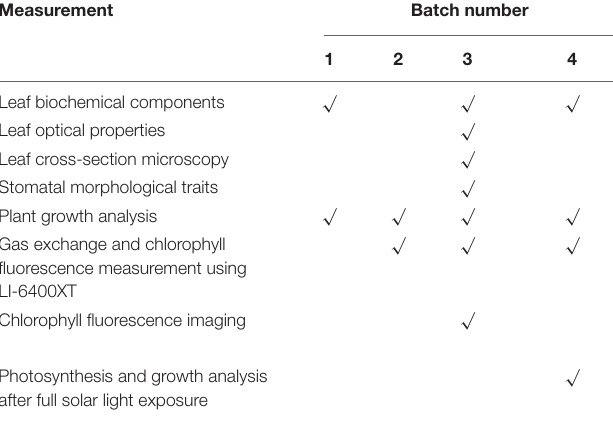
TABLE 2 | Measurements conducted in each batch of the experiment.